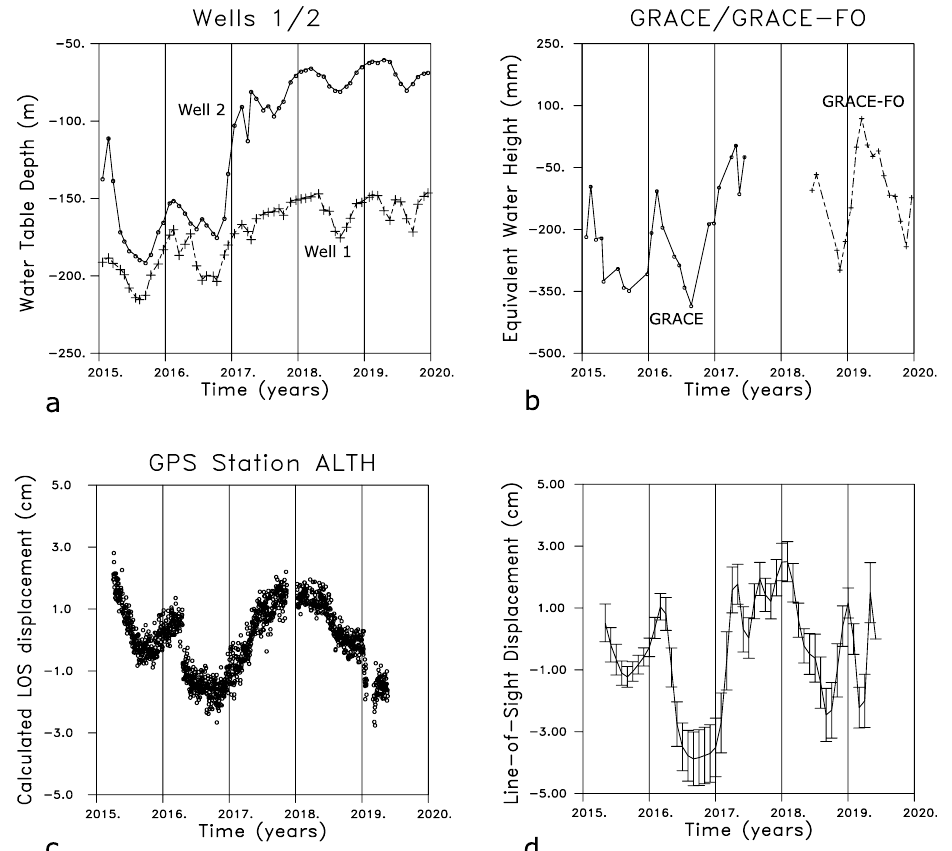
Figure 9. ( a ) Water table variations at well 1 (365322120401203) and well 2 (365325120391504) that are within a few hundred meters of each other. The continuous water table observations are available from the site: https:// data. cnra. ca. gov/ datas et/ conti nuous- groun dwater- level- measu remen ts The locations of the wells are indicated in Fig. 4 by an open circle and the label well 2. ( b ) Equivalent water height changes for a point corresponding to ( c ) Vertical displacements from the GPS station ALTH near the two water wells 1 and 2. The open circles indicate values from the daily recordings. (d) Estimated line-of-sight displacements at the location of water